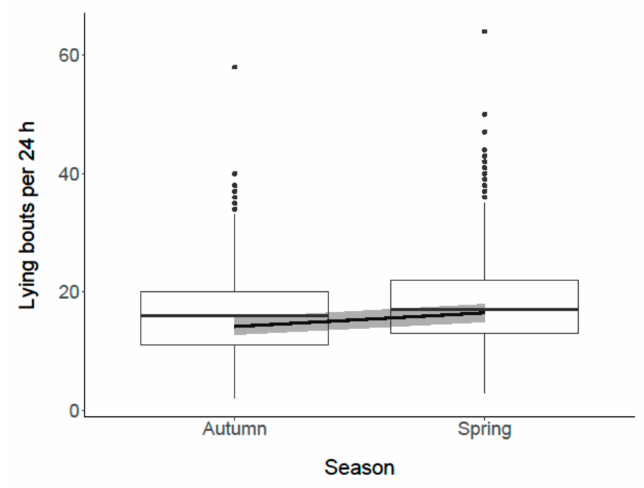
Figure 10. Association between “season” and the number of lying bouts (per 24 h) of the goats. Box plots show medians and interquartiles. The black line represents the model estimate, the gray colored area the 95% confidence